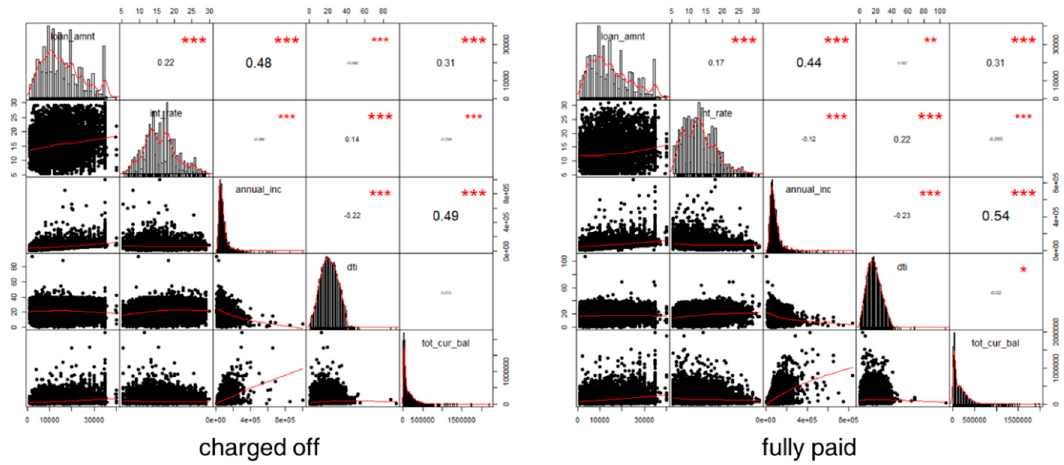
Figure 1. Correlation plot for the loan status. * means low correlation, ** middle correlation, and *** high correlation.